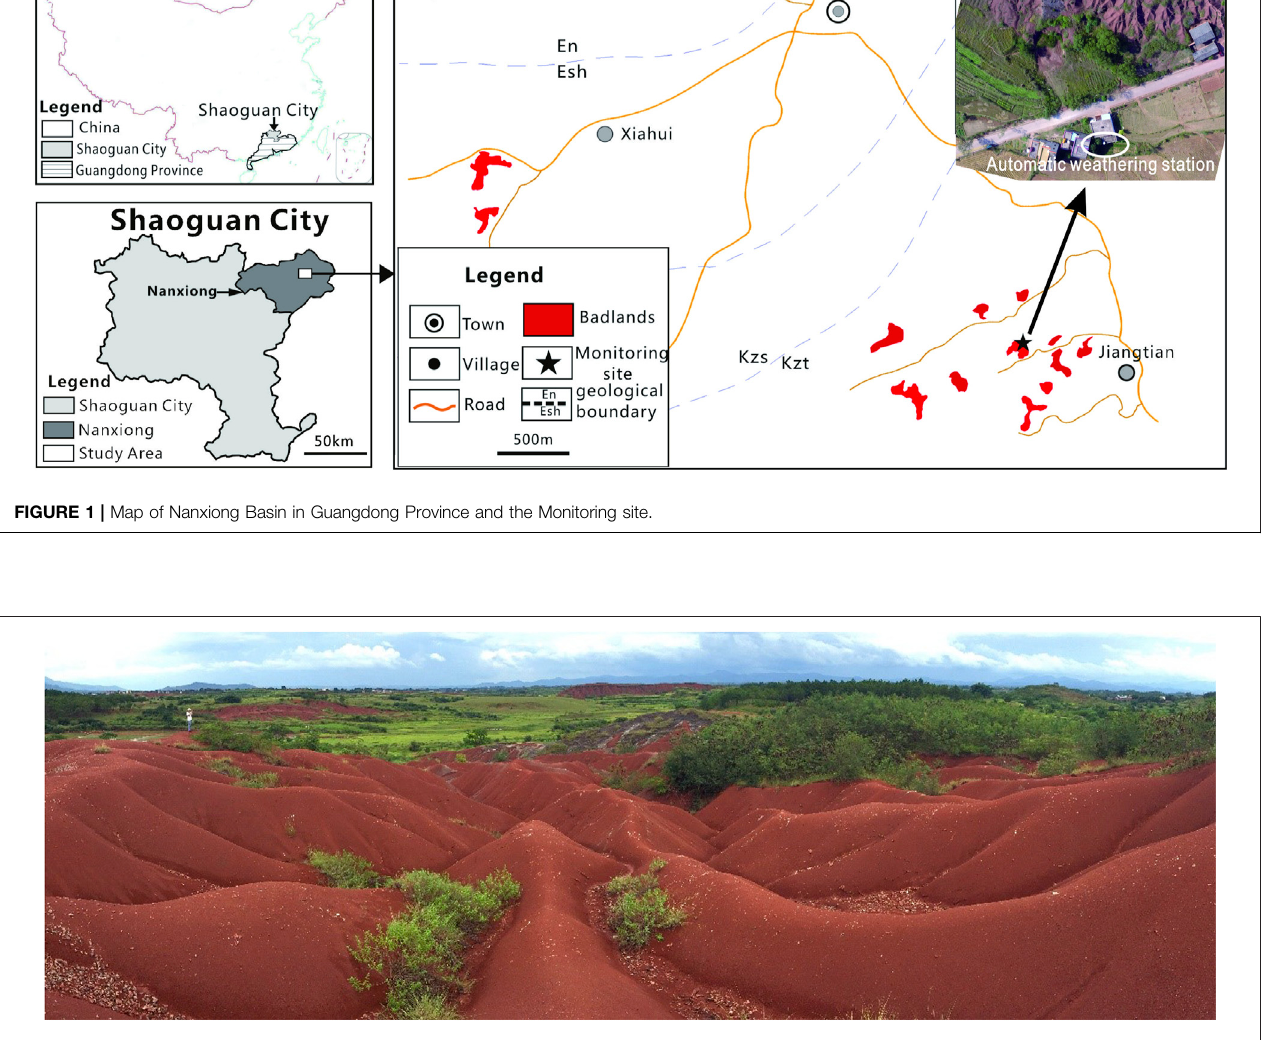
FIGURE 2 | Badland landscape in Nanxiong Basin (Peng et al., 2015).